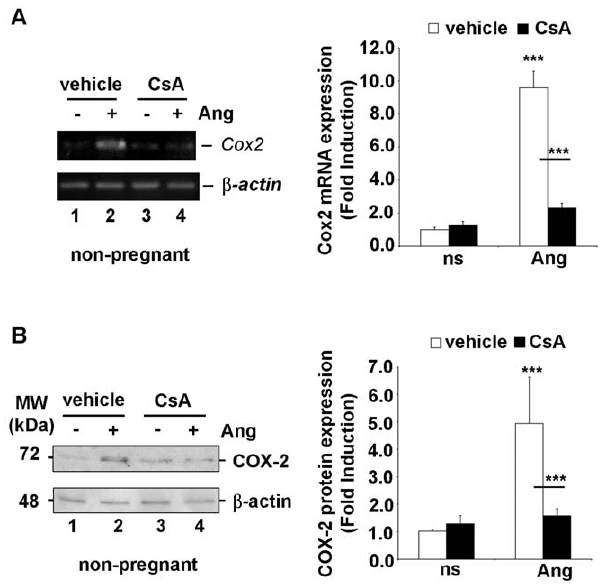
Figure 2. Ang II induced COX-2 expression in primary ESC of non-pregnant rats. Expression was abrogated by CN inhibition. (A) Cox-2 mRNA was amplified from total RNA purified from primary cultures of ESC, by semi-quantitative RT-PCR. The transcript of the b